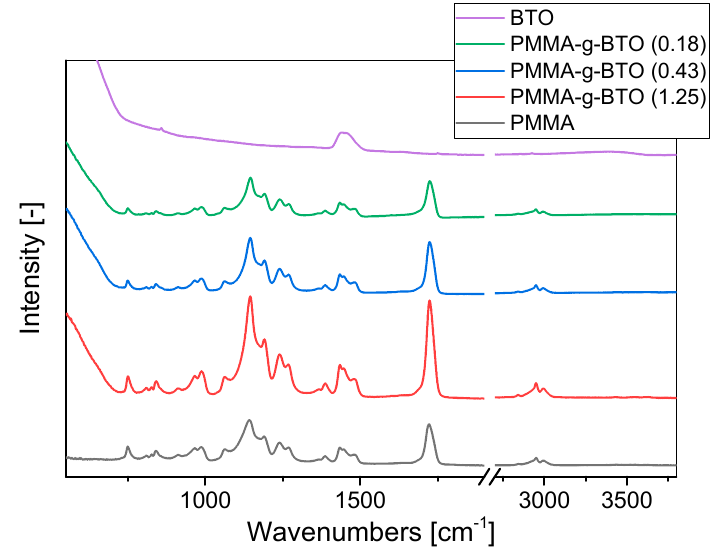
Figure 7. ATR FTIR spectra of BaTiO 3 , PMMA, and PMMA- g -BTO composites. Most of the absorbance bands are located at the same wavenumbers independently of the sample. Only for three bands, significant changes were found. Bands relating to C=O stretching (1722 cm − 1 ) and C–O–C stretching (1141 cm − 1 ) shift toward higher wavenumbers with increasing BTO content (see Figure 8), while the intensity of the line assigned to CO 2 − vibration (855 cm − 1 ) increases with increasing BTO content. (Figure S5).